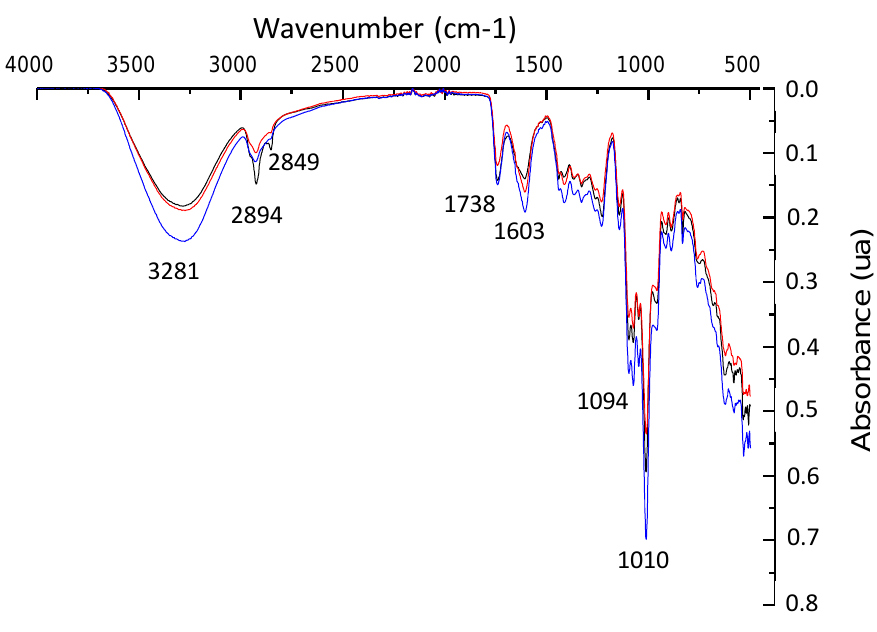
Figure 3. FTIR spectra of PC (------), PC-1ZnO (------) and PC-3ZnO (------) films.